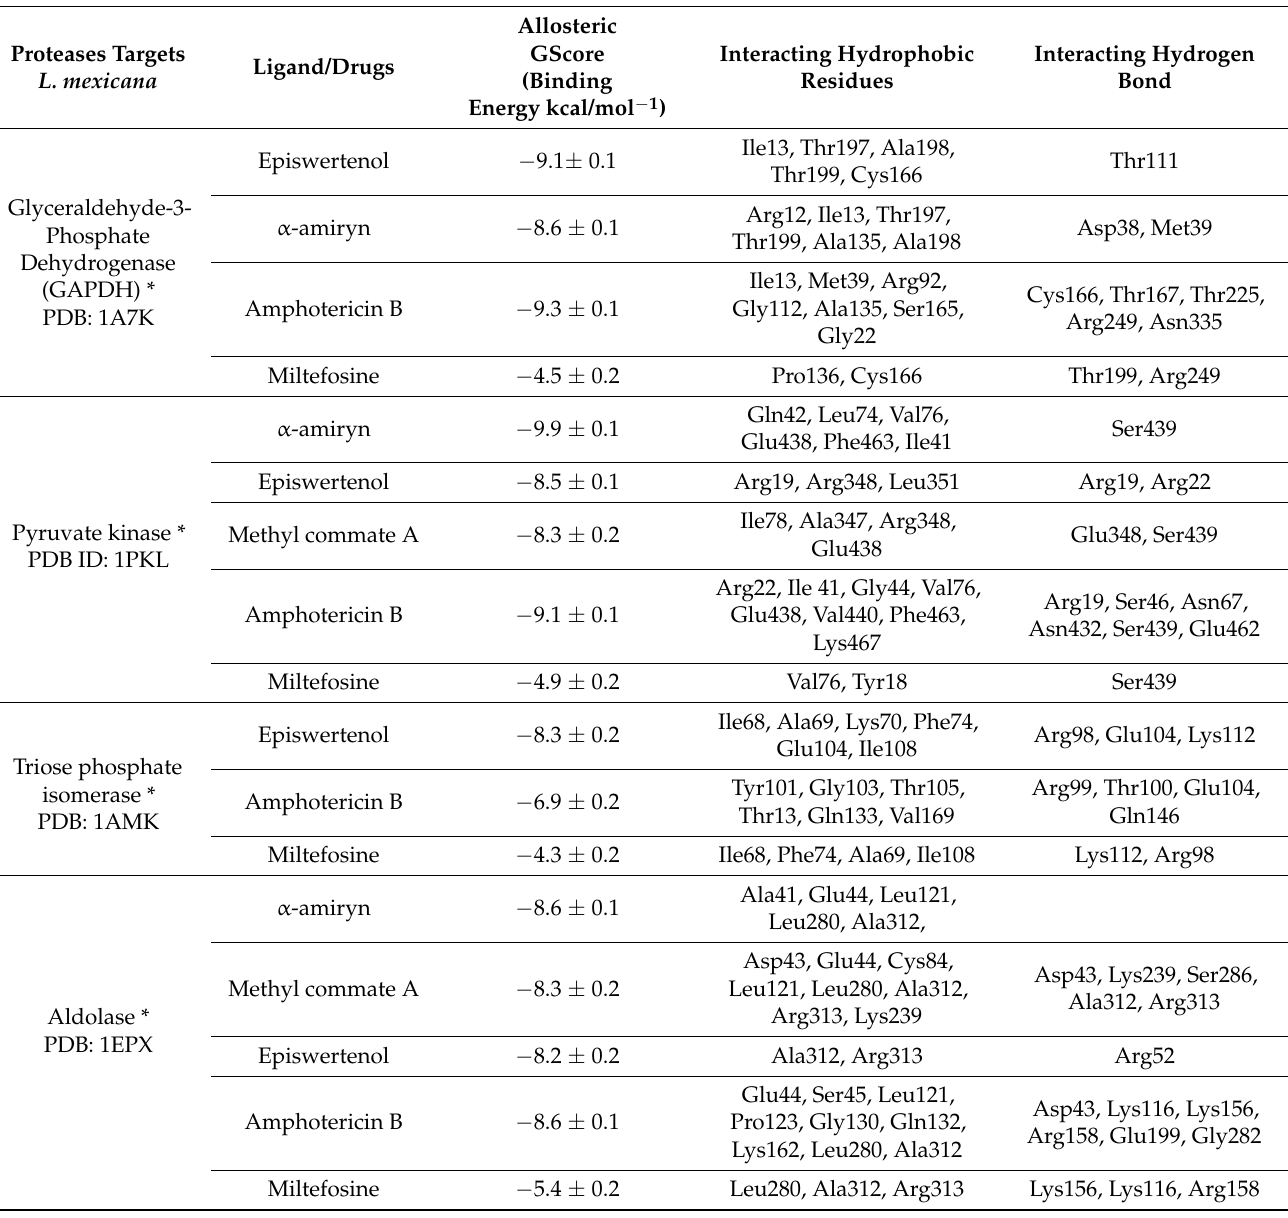
Table 1. Scoring function estimation of binding affinity energy and molecular interactions of phyto- components identified in the Ma-24F fraction of leaves of M. alceifolia by GC-MS upon docking in a potential allosteric sites of significant L. mexicana target proteins for AutoDock Vina